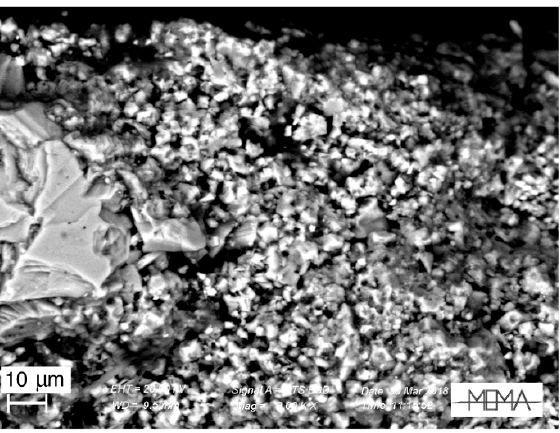
Figure 11. Sample C3, after 5 days of experiments. Details of the depletion zone with carbonate with higher abundance of Fe and Mg (and/or Mn). Images taken from a piece on a stub.